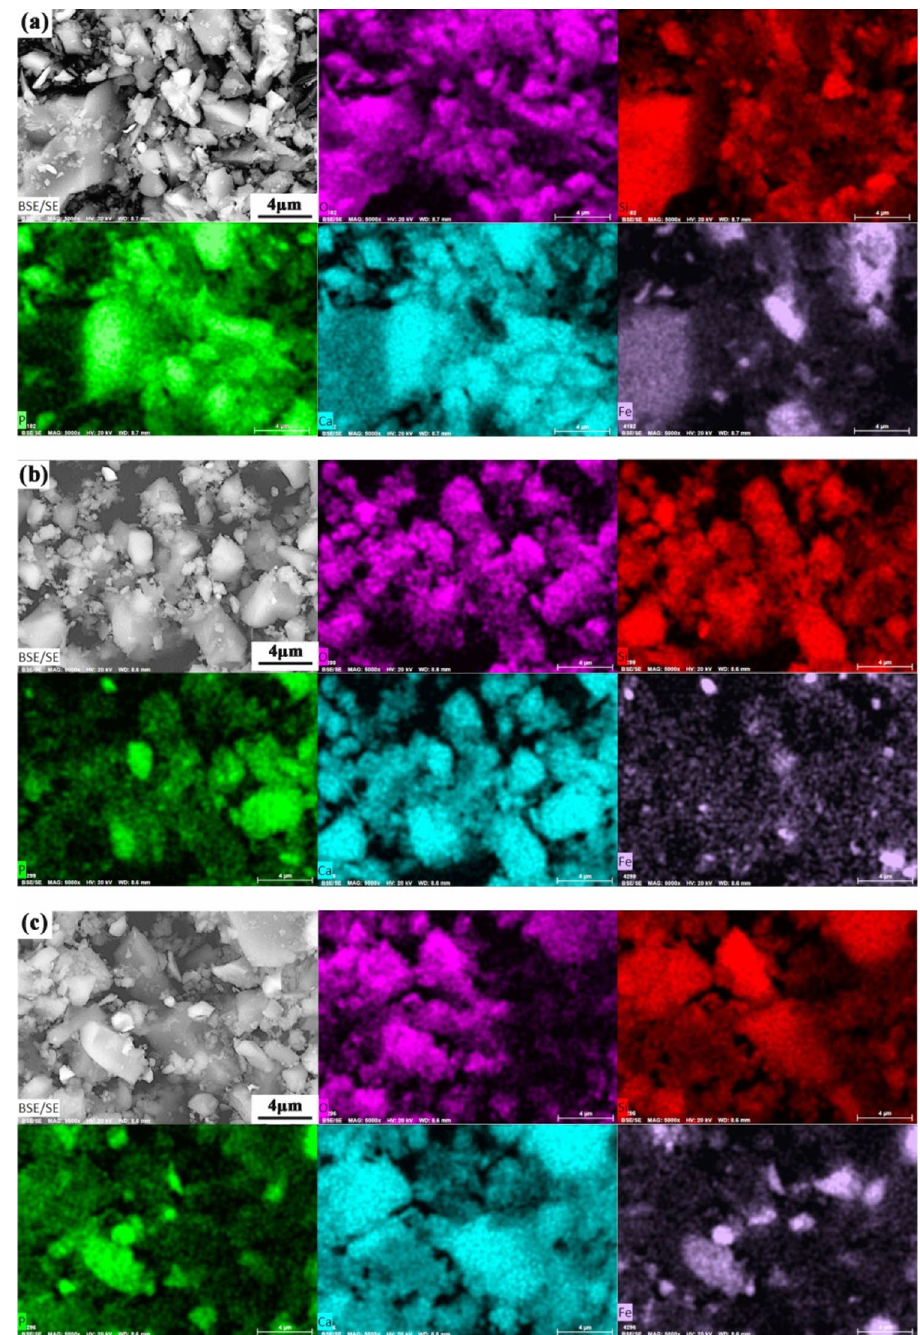
Fig. 6 SEM analysis of reduc- tion roasting products at differ- ent temperatures ((a) 1200 ℃ ; (b) 1250 ℃ ; (c) 1300 ℃